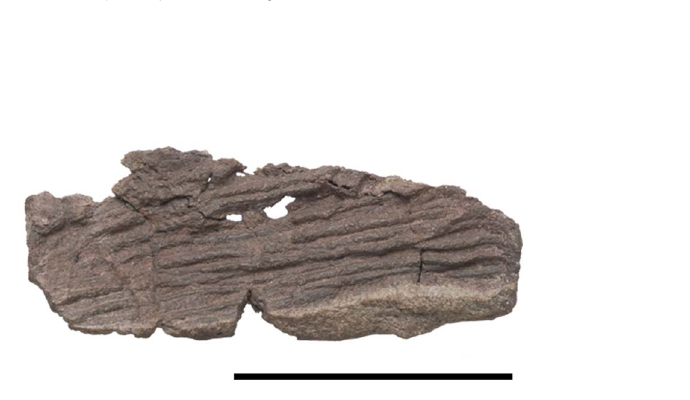
Figure 9. Caudal vertebrae of Pseudochampsa ischigualastensis (PVSJ 567) in (A, B) ventral/left lateral, and (C, D) dorsal/right lateral views. Close-up of two middle caudal vertebrae in dorsal view in (C). Abbreviations: bne, base of neural spine; ce, centrum; ch, chevron; hc, hemal canal; ne, neural spine; tpr, transverse process. Scale bar equals 5 cm and 1 cm in close-up of (C).